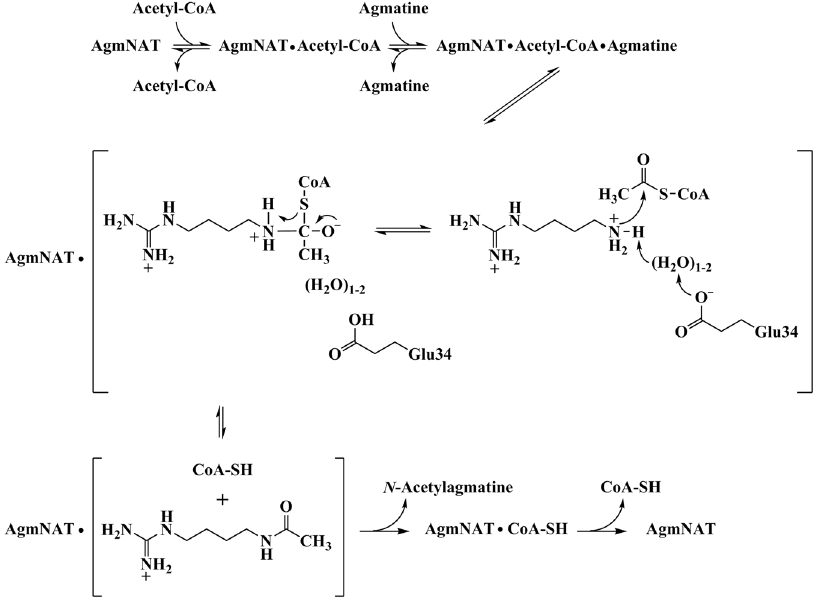
Figure 7. Proposed chemical mechanism for D. melanogaster